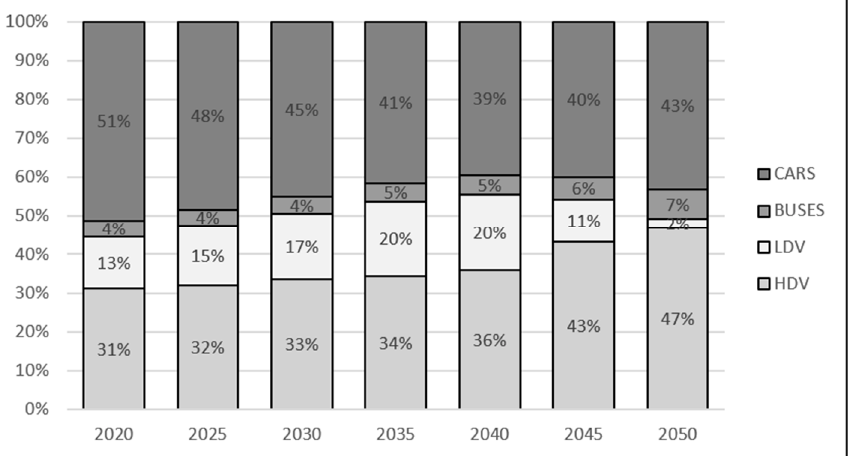
Figure 12. Structure changes of CO 2 emissions in Polish road transport in the years 2020–2050 [NEU scenario]. Source: own calculations based on TR 3 E model results.